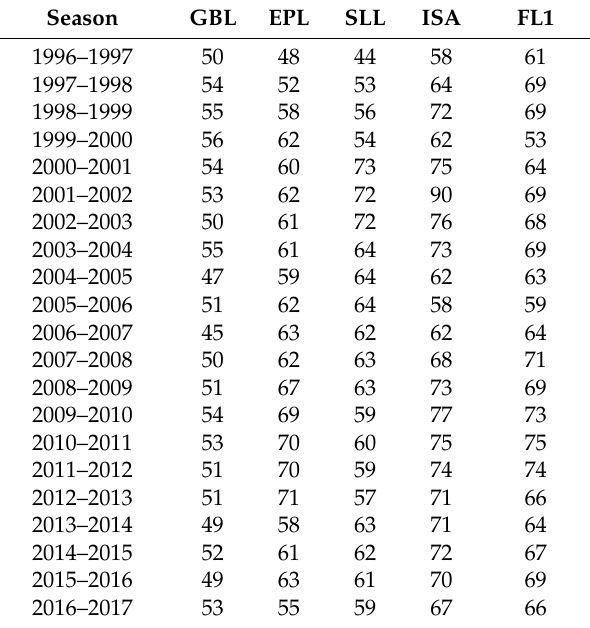
Table 4. The ratio between gross payroll * (wage cost) and total revenue, Big Five